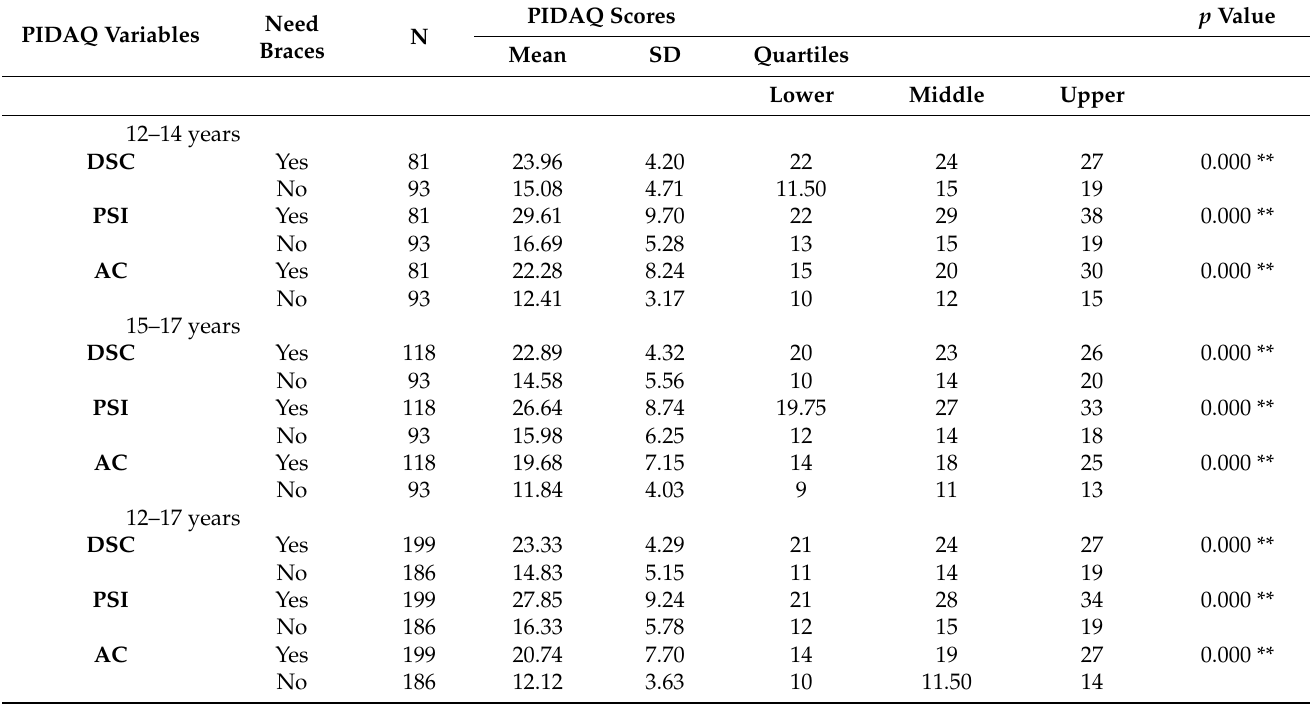
Table 9 shows the associations between the PIDAQ(A) subscales and self-perceived need for braces. Self-perceived need for braces was significantly associated with all sub- scales of the PIDAQ(A) for all age groups. The IOTN-DHC was significantly associated with the PIDAQ(A) subscales for all age groups (Table 10). The mean PIDAQ(A) scores between subjects who were rated by the investigator with a lower grade of malocclusion and those with a greater grade of malocclusion for all subscales ( p < 0.01) were statistically significantly different. Table 9. Discriminant validity: association between the PIDAQ(A) and need for orthodontic treatment. PIDAQ Variables